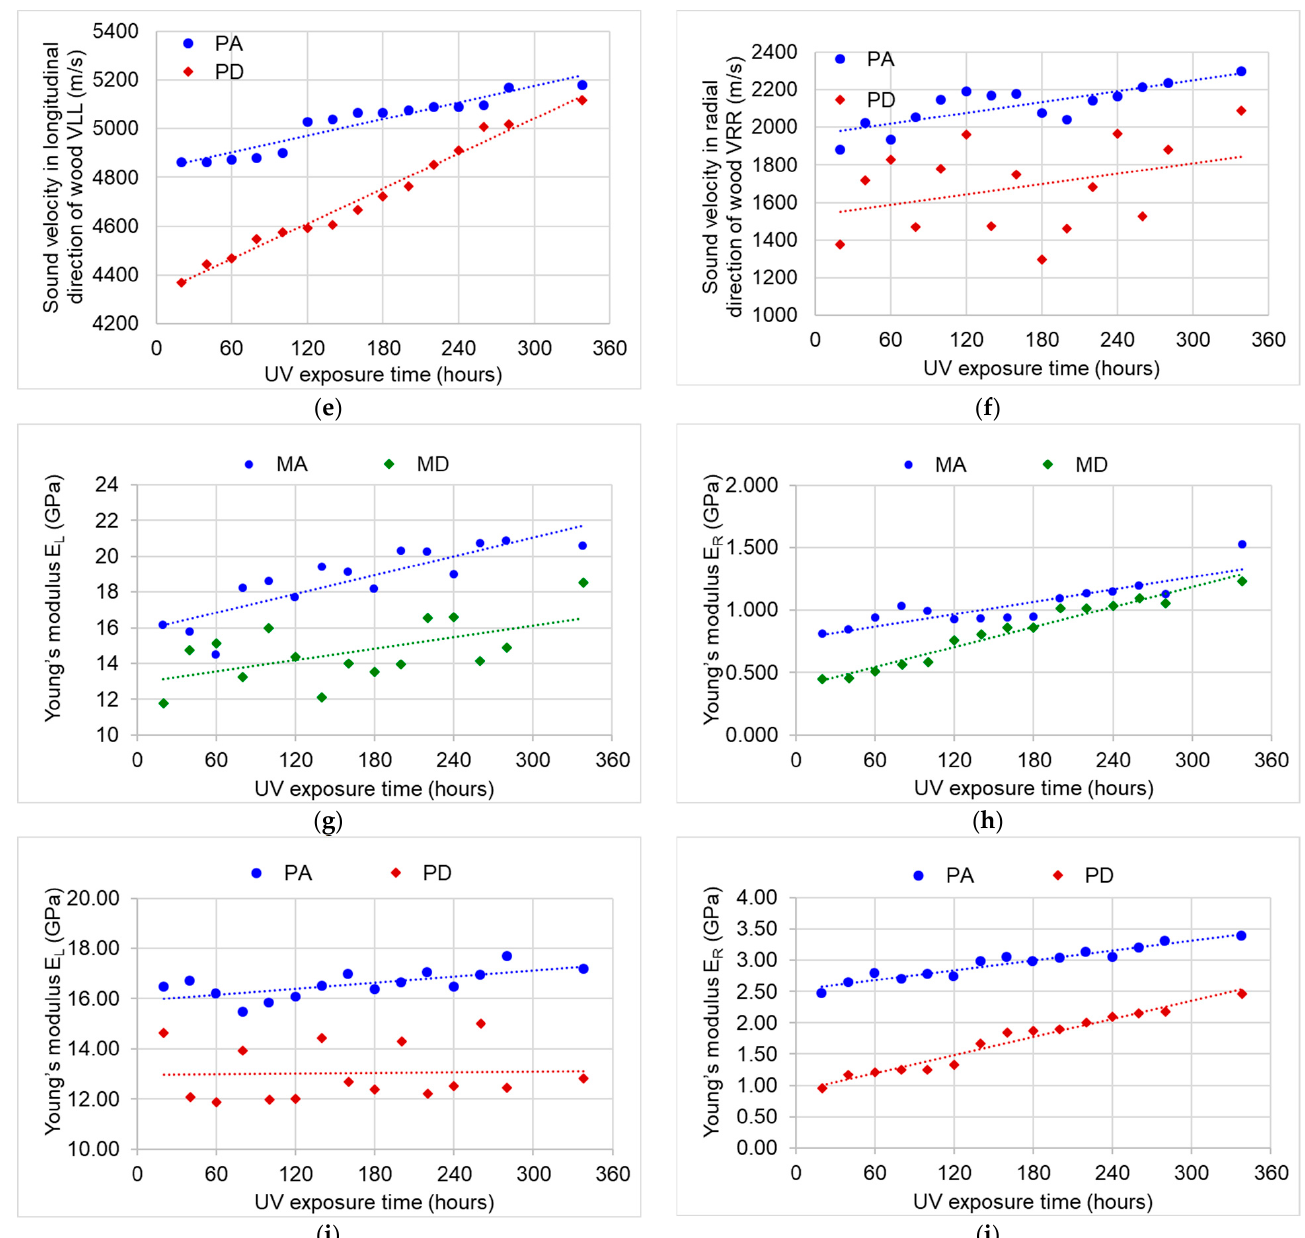
Figure 15. The variation in the physical, acoustic, and elastic parameters with aging duration: ( a ) density variation in the spruce samples; ( b ) density variation in the maple samples; ( c ) variation in sound velocity in spruce wood in the longitudinal direction; ( d ) variation in the sound velocity in the spruce samples in the radial direction; ( e ) variation in the sound velocity in the sycamore maple samples in the longitudinal direction; ( f ) variation if the sound velocity in the sycamore maple samples in the radial direction; ( g ) variation in the Young’s modulus in the spruce samples in the longitudinal direction; ( h ) variation in the Young’s modulus in the spruce samples in the radial direction; ( i ) variation in the Young’s modulus in the sycamore maple samples in the longitudinal direction; ( j ) variation in the Young’s modulus in the sycamore maple samples in the radial direction. Table 4 summarizes the acoustic and elastic parameters measured during exposure to thermal and UV treatment. It can be observed that the only property that registered a decrease in value was the density of both species and Table 4. Summary of acoustic and elastic parameters determined before and during exposure to UV. Legend: ρ —density (kg/m 3 ); V LL —sound velocity in wood in the longitudinal direction, (m/s);